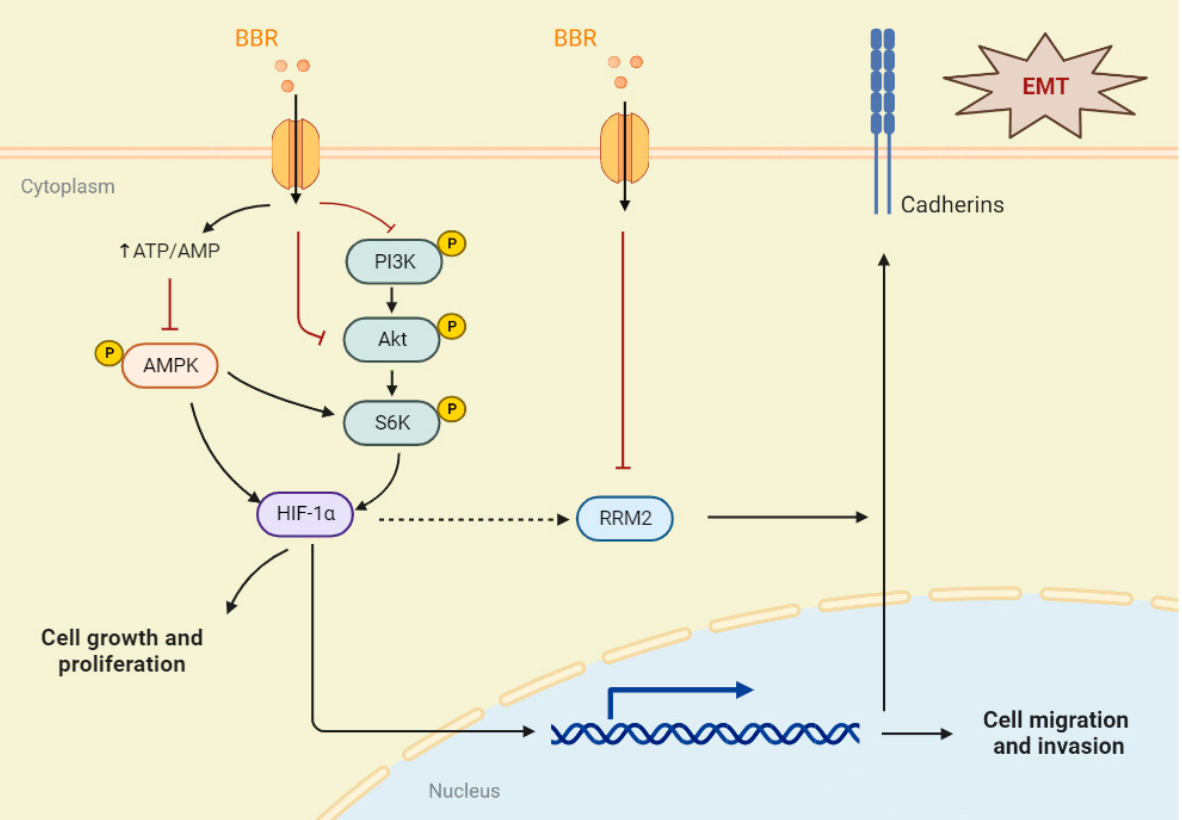
Figure 8. Schematic diagram of the core pathway and target of BBR on BRCA cells. A graphic illustration of the proposed mechanism in this study.